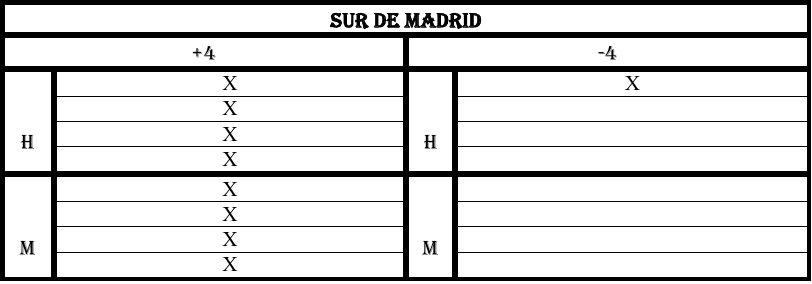
Figure 3. Data on the informants surveyed in the eastern area of Madrid.